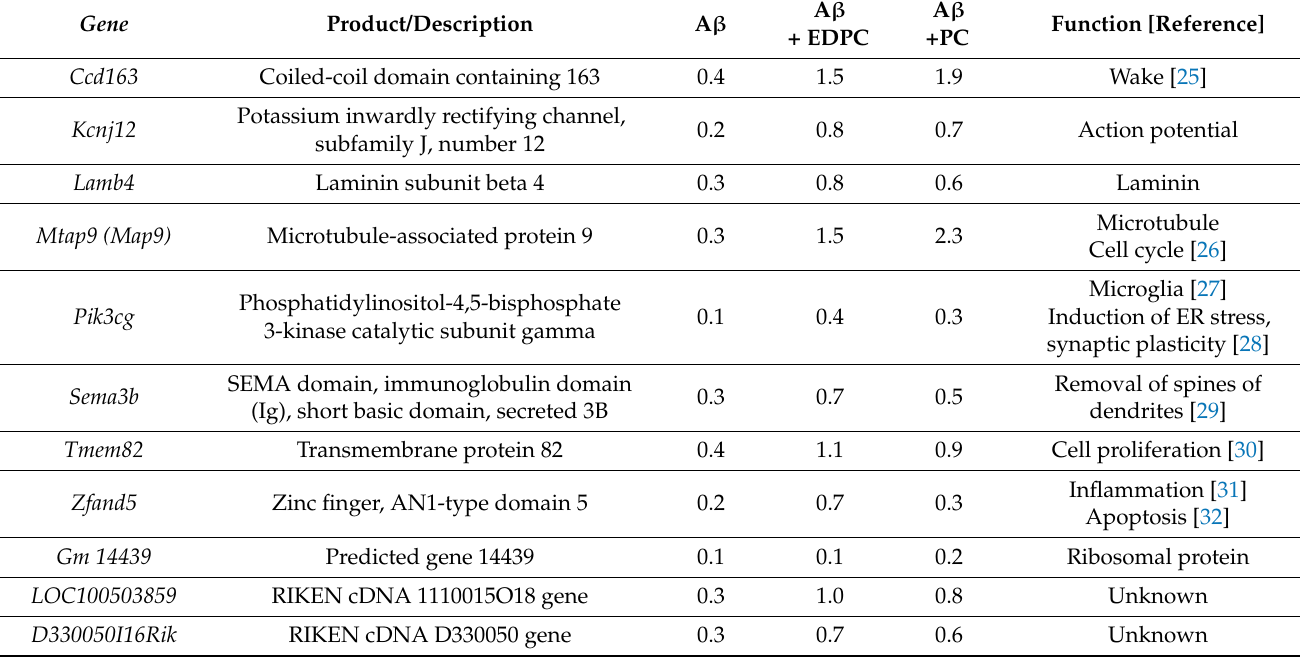
Table 6. Fold change values of the upregulated EDPC-and PC-related genes with respect to the sham group, excluding those shown in Table 5.